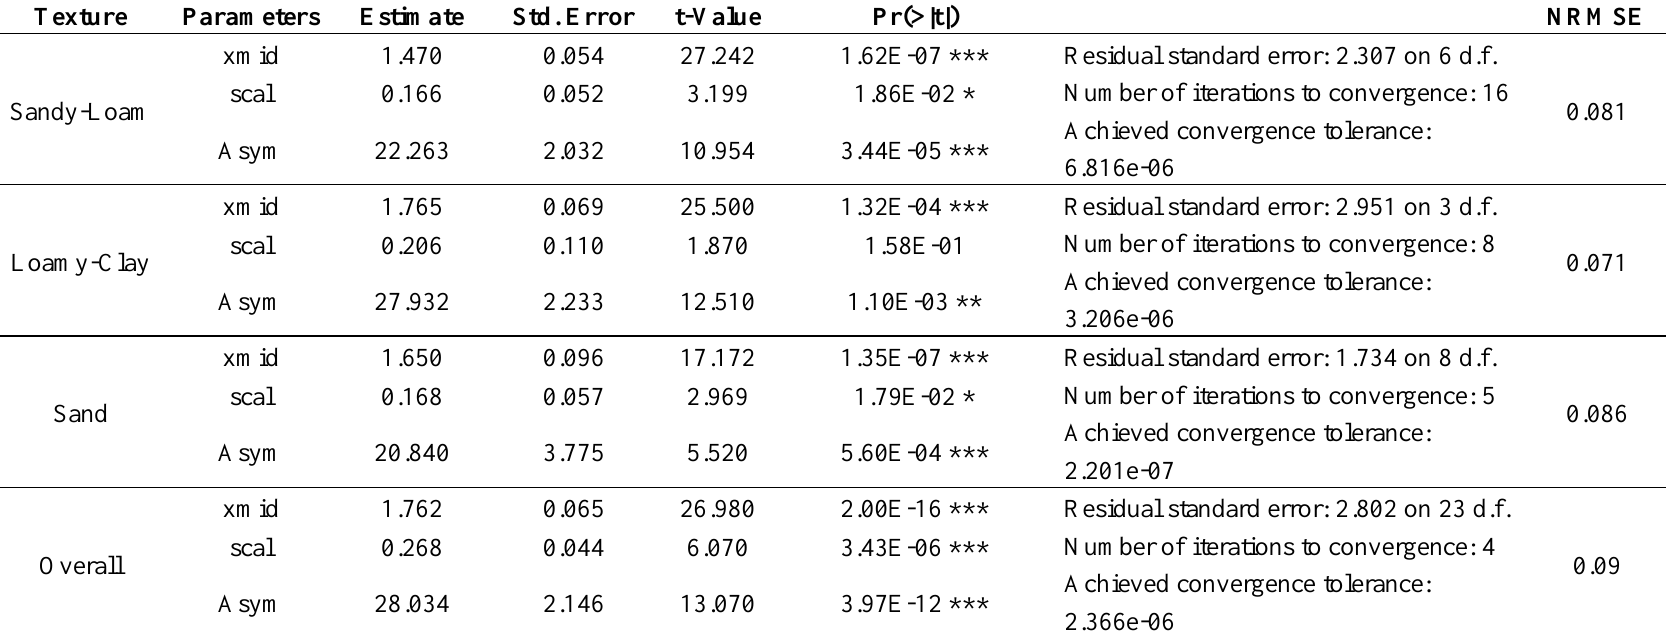
Table 3. Summary statistics of calibration models for soil water content sensors. For each soil texture and for the overall model the logistic function parameters estimates were reported together with their standard error and significance, normalized root mean square error (NRMSE) as a measure of goodness of fit. The asterisks ―*‖indicate the coefficients significance levels. The symbols are displayed as follows: Any p -value < 0.001 was designated with three (***) asterisks; p -values >= 0.001 and <= 0.01 are shown with two (**) asterisks, p -values > 0.01 and < 0.05 are shown with one (*)